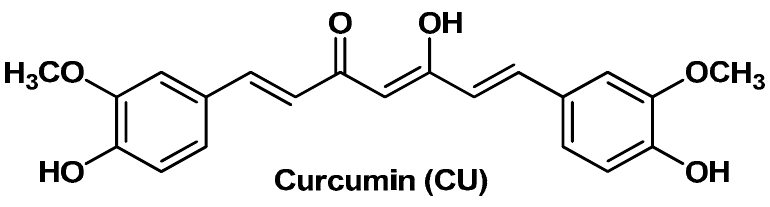
Figure 10. Chemical structure of curcumin (CU).